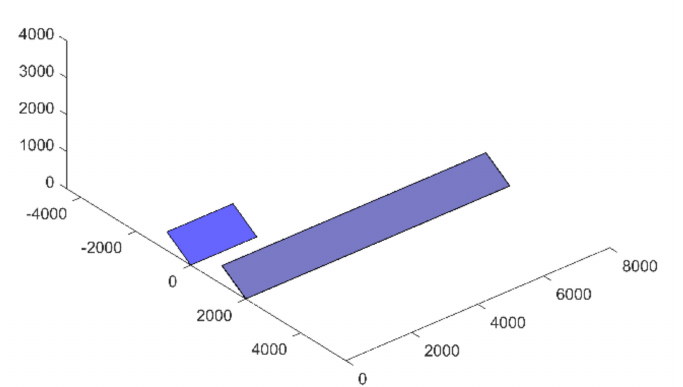
Figure 12. First module of the second row being shaded by the row in front. The shading factor for the inter-row shading is calculated for each module of the second row, being shaded by an obstacle with the size of the row in front.